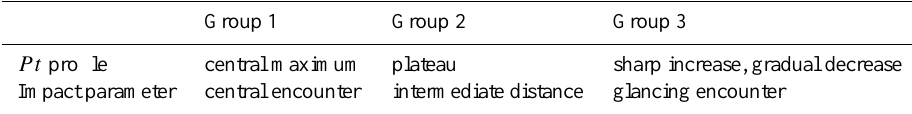
Table 1. Pt categorization according to Jian et al., 2006.